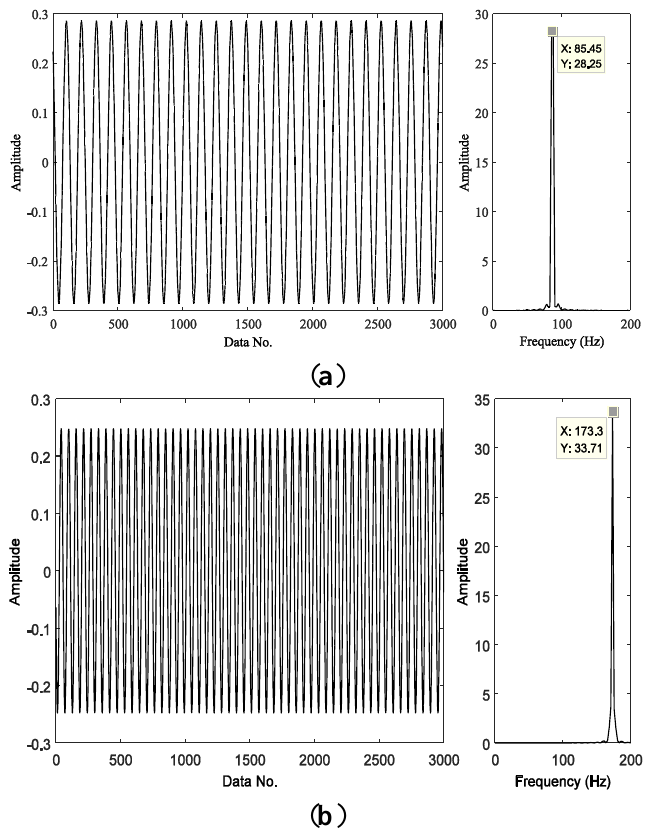
Figure 8. Harmonics detected and their frequencies from envelope samples of the signal shown in Figure 7: ( a ) the first harmonic and its frequency, and ( b ) the second harmonic and its